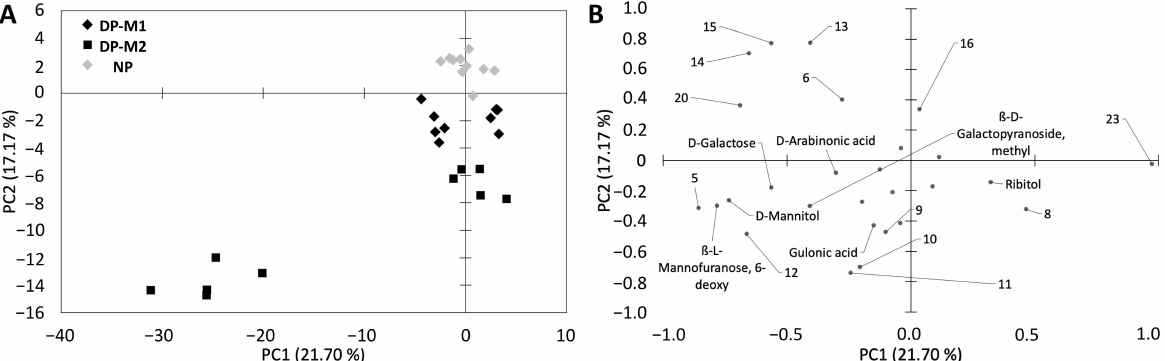
Figure 3. PCA score ( A ) and loading ( B ) plots of the metabolite profile of root-deprived Musa AAA cv. Williams microplants at the Rooting Phase coming from meristem M1 (N1–N10: normal plants, D1–D10: dwarf plants), for which the PCA was performed. Additionally, the plants M2 DP (11–19) are also visualized as an assessment set. Metabolites numbers in the loading plot correspond to Table 1.